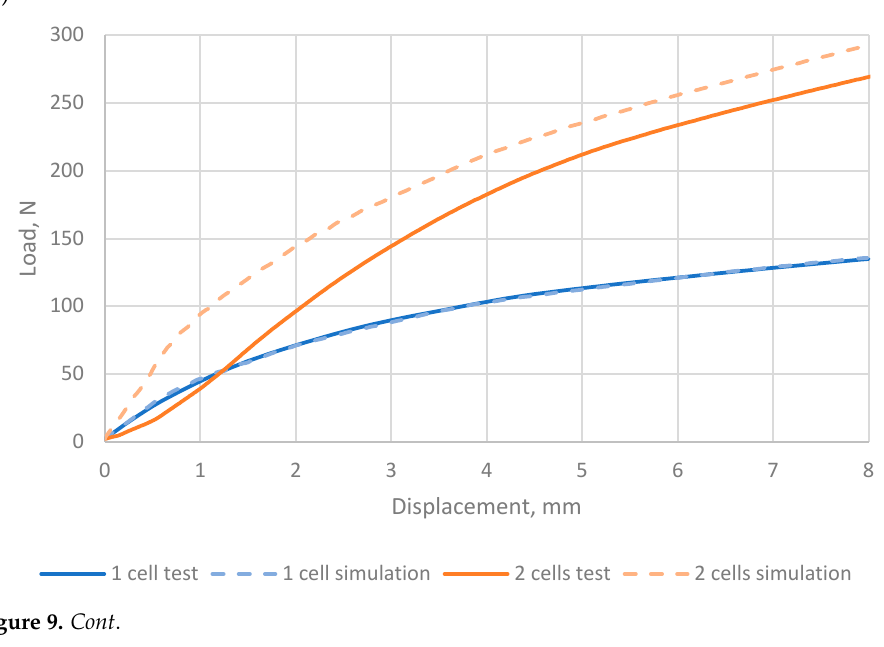
Figure 9. Comparison between the simulation and physical 3PB test data for ( a ) single and double cells bent around the X axis and ( b ) single and double cells bent around the Y axis. 4.1.5. Confined Compression Figure 10a,b show the predicted force ‐ displacement characteristics (dashed) compared to physical test (solid) for stacks of 1, and 2 cells subjected to confined compression in the X and Y planes respectively. It was anticipated that for multiple stacked cells the force, at a given displacement, would be equal to that of a single cell multiplied by the number of cells in the stack. This is equivalent to a number of similar springs with equivalent characteristics, in par ‐ allel, i.e., the force required to achieve a given displacement for a system with N springs will be N times the force required to achieve the same displacement with a single spring. As can be seen from Figure 10a,b, stacked cells do not generate the expected response. In the confined compression load case, the cells are subject to a through thickness constraining load. Also, there is a ‘soft region’ at the end of the cell which compresses preferentially before the initial